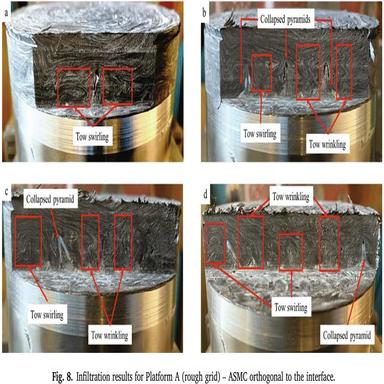
Summary of mechanical properties of the hybrid joints in the different tested configurations; 10a) Maximum Load; 10b) pullout failure energy.